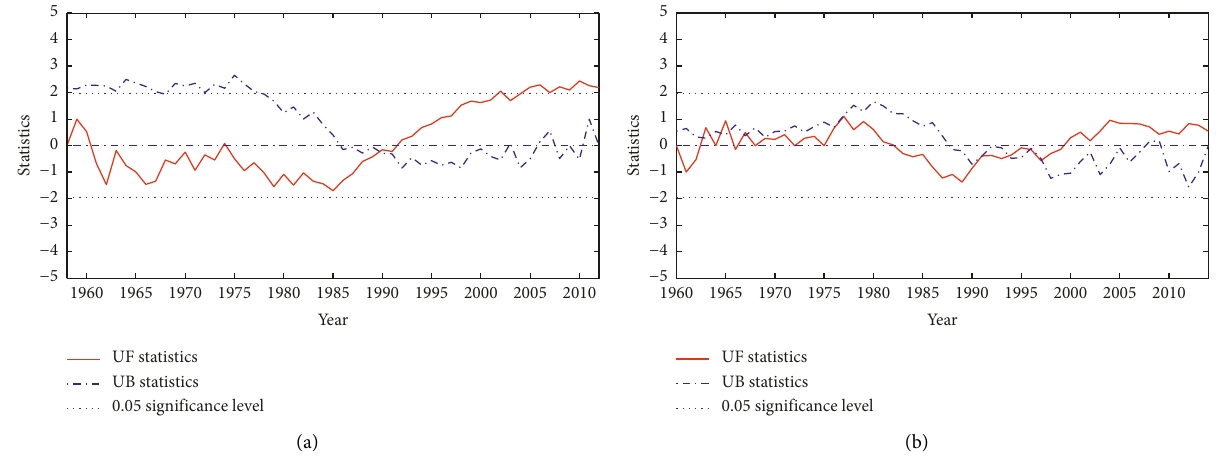
Figure 6: The Mann–Kendall abrupt change test of PX5D in Xihua (a) and PX10D in Shangqiu (b).